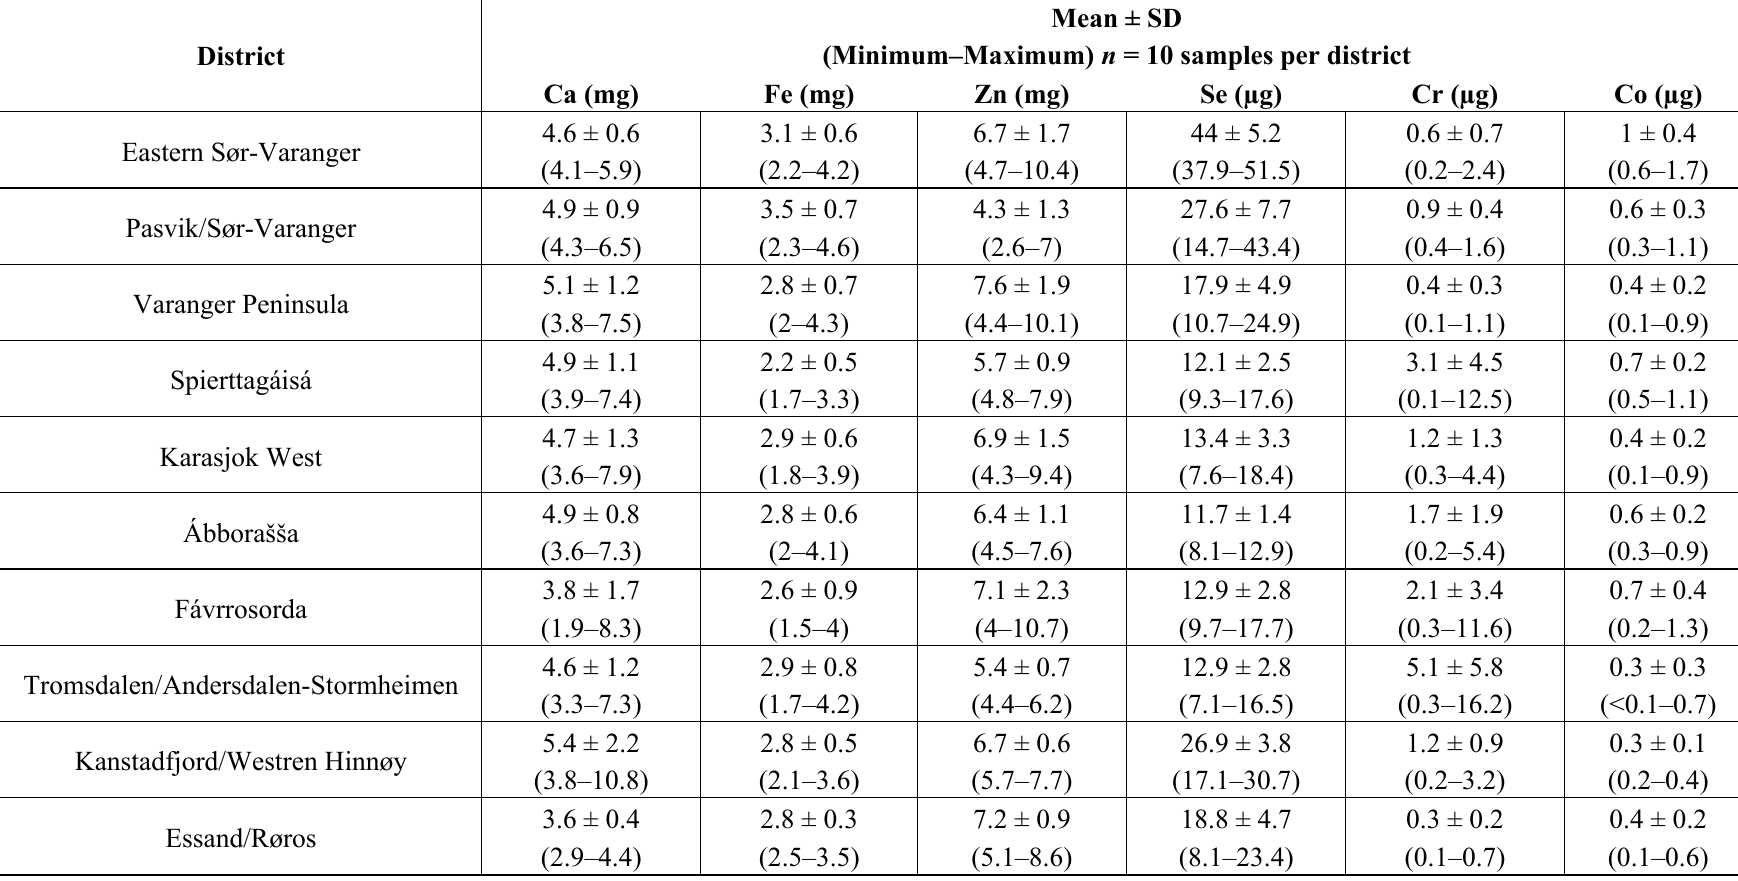
Table 6. Concentration of the selected essential elements per 100 g (ww) across grazing